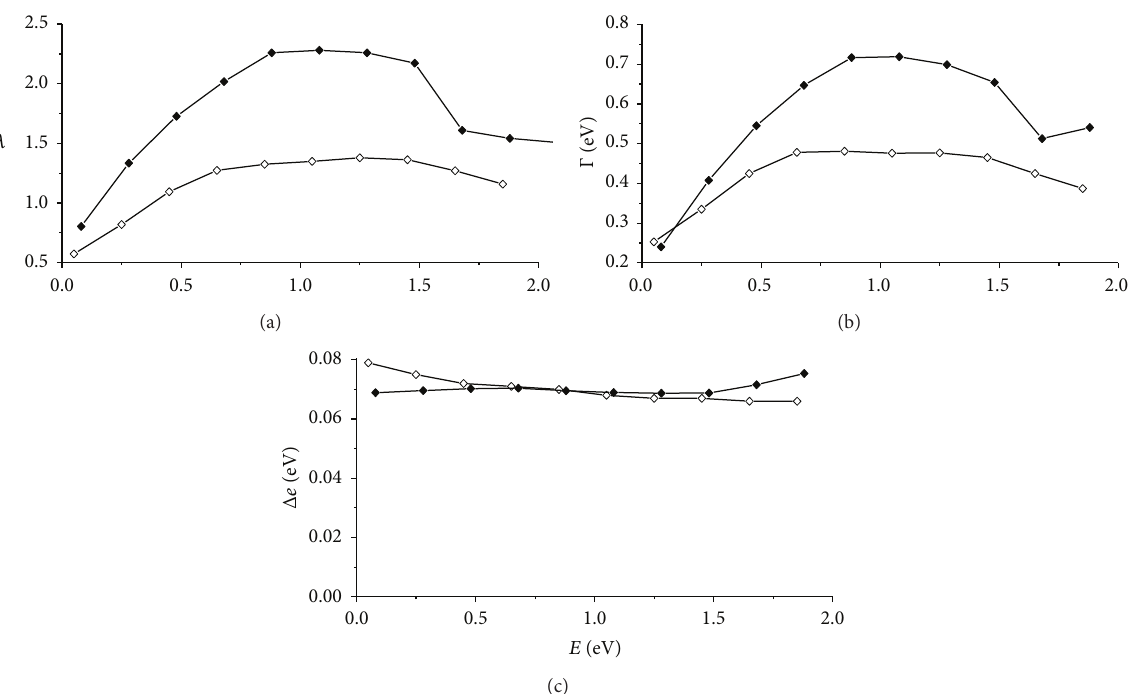
Figure 3: The characteristics of the hole-phonon and electron-phonon relaxation for rutile depending on the excess energy 𝐸 . The sense of the plots is the same as in Figure